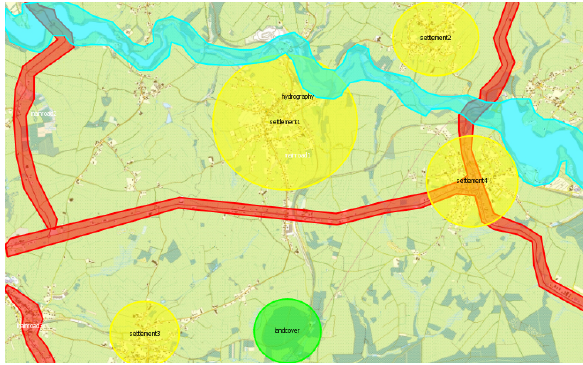
Figure 14. Selected